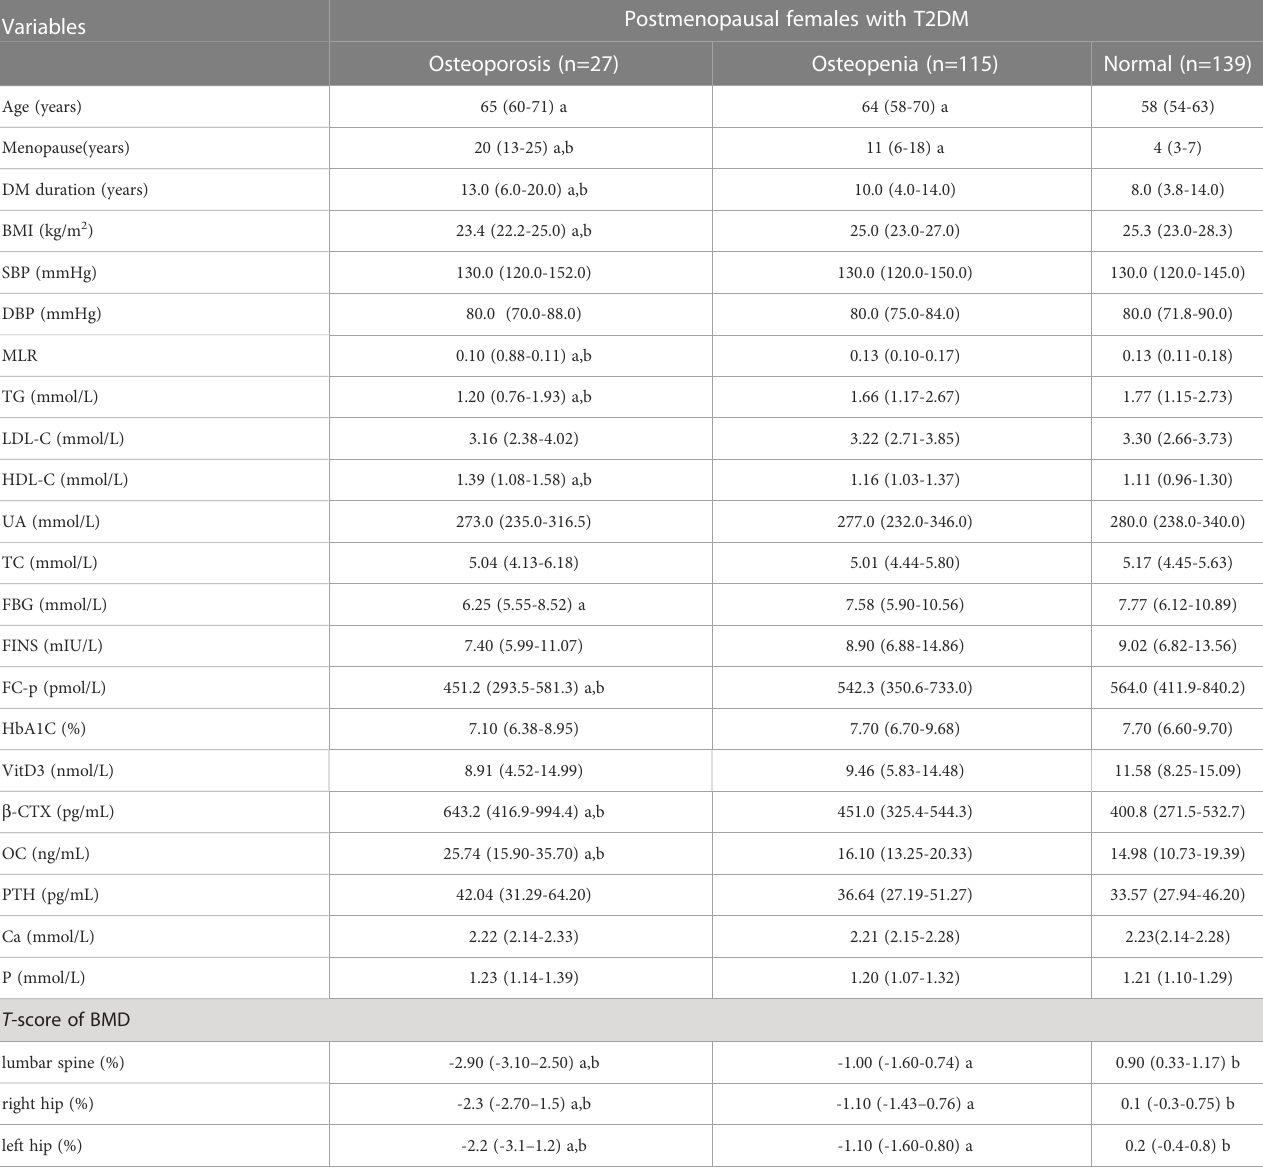
TABLE 1 Clinical characteristics in postmenopausal females with T2DM. vs.normal a, vs. Osteopenia